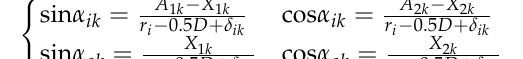
Figure 1. The coordinate systems for ball bearing: ( a ) Axial section and x axis coincided with the rotation center line; ( b ) Traverse section and ball position angle ( 2 ( 1)